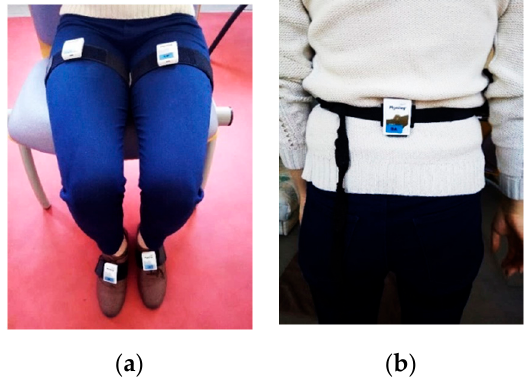
Figure 5. ( a ) Four modules placed on thighs and feet; ( b ) One module placed on the lower